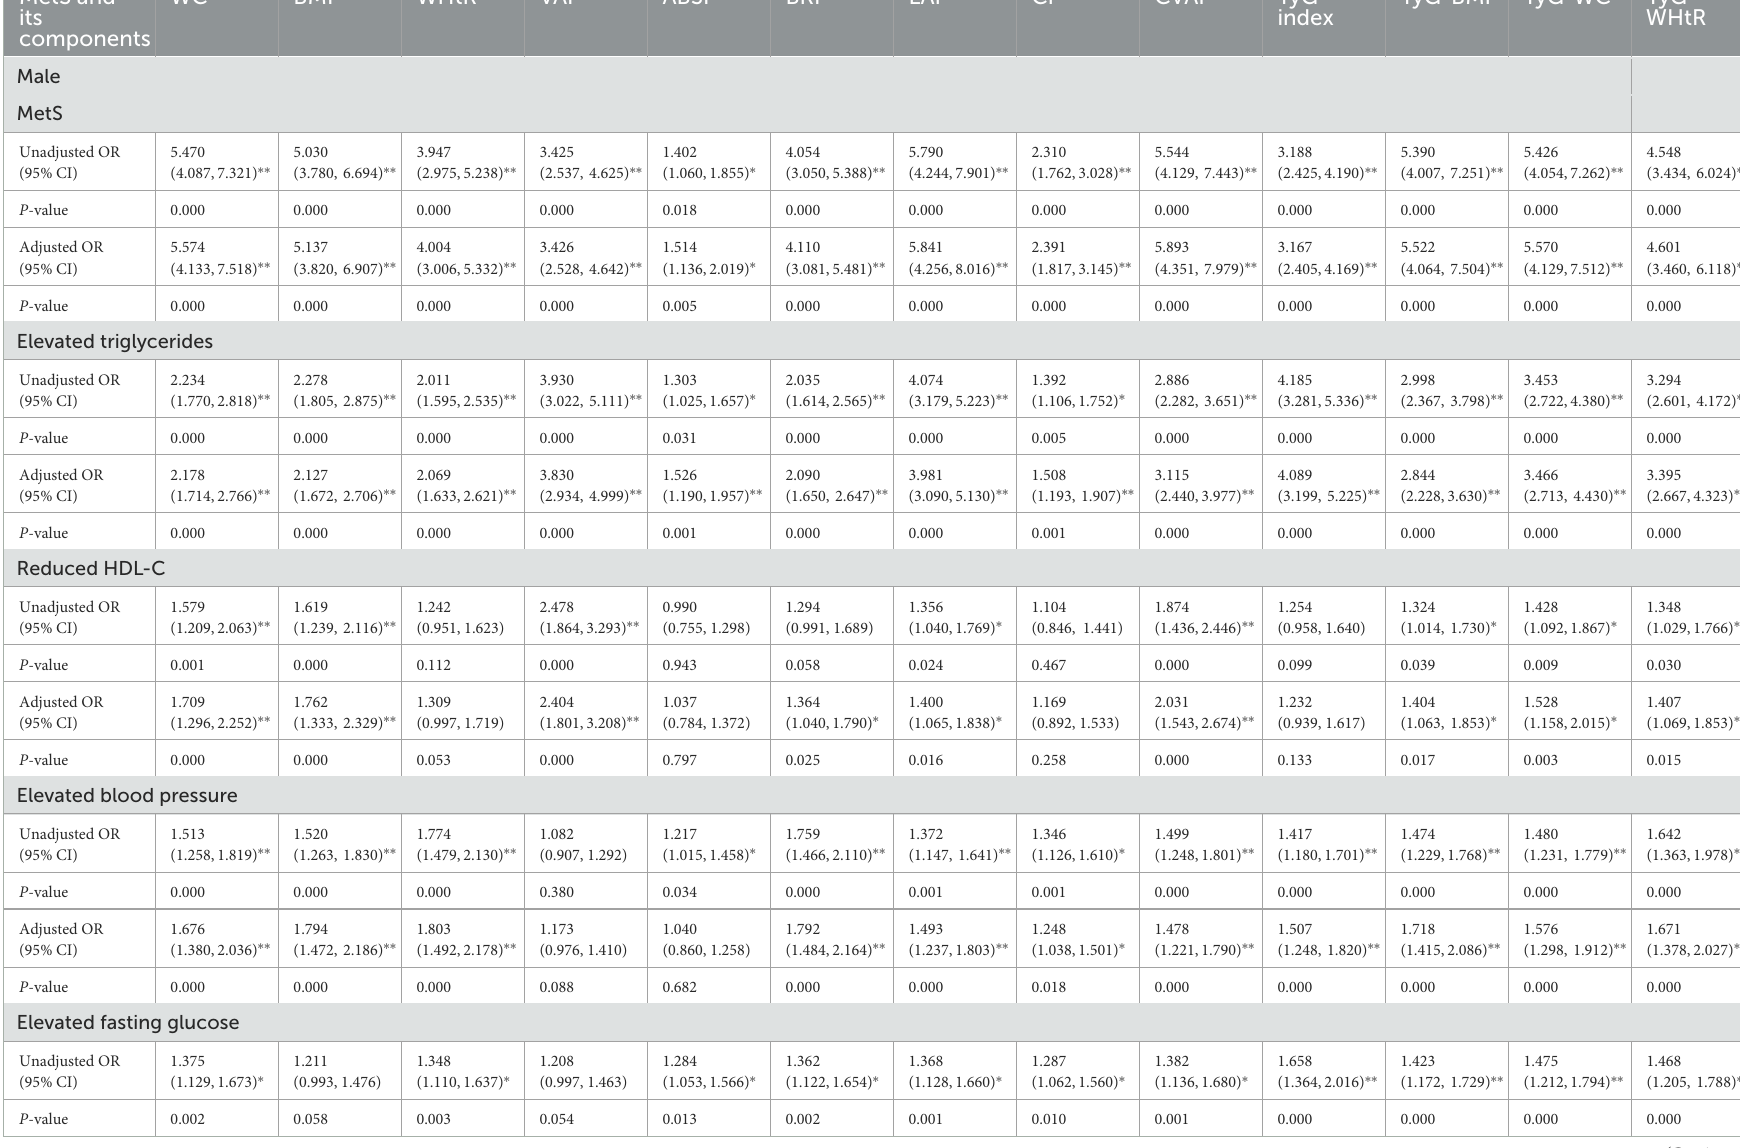
TABLE 4 Associations of obesity- and lipid-related indices with MetS (CHARLS2011–2015) and its components. MetS and its